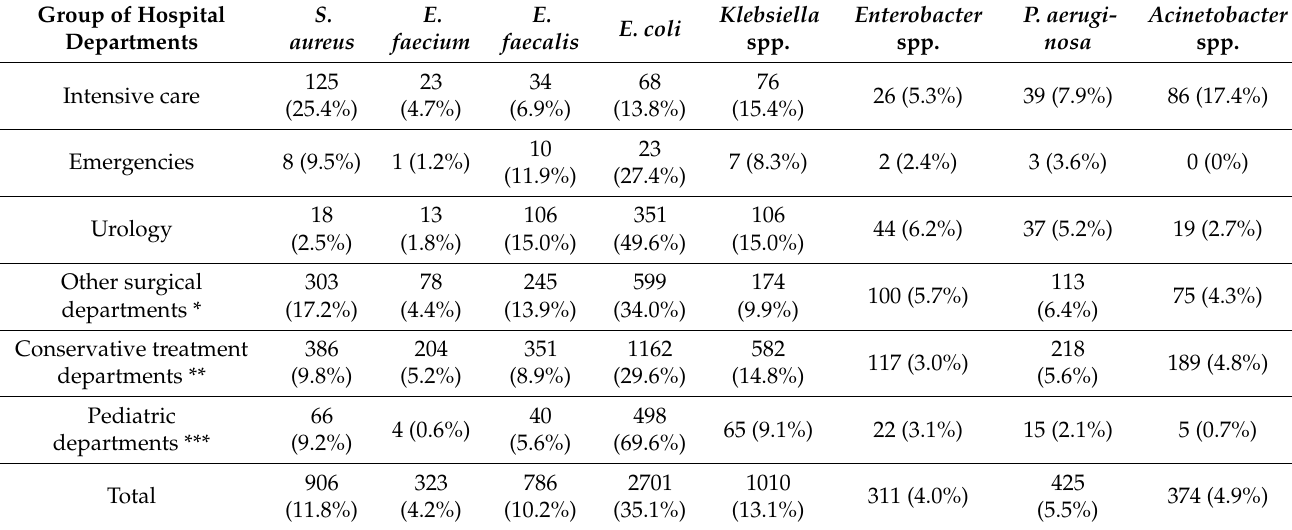
Table 2. Etiological factors of infections diagnosed in different hospital